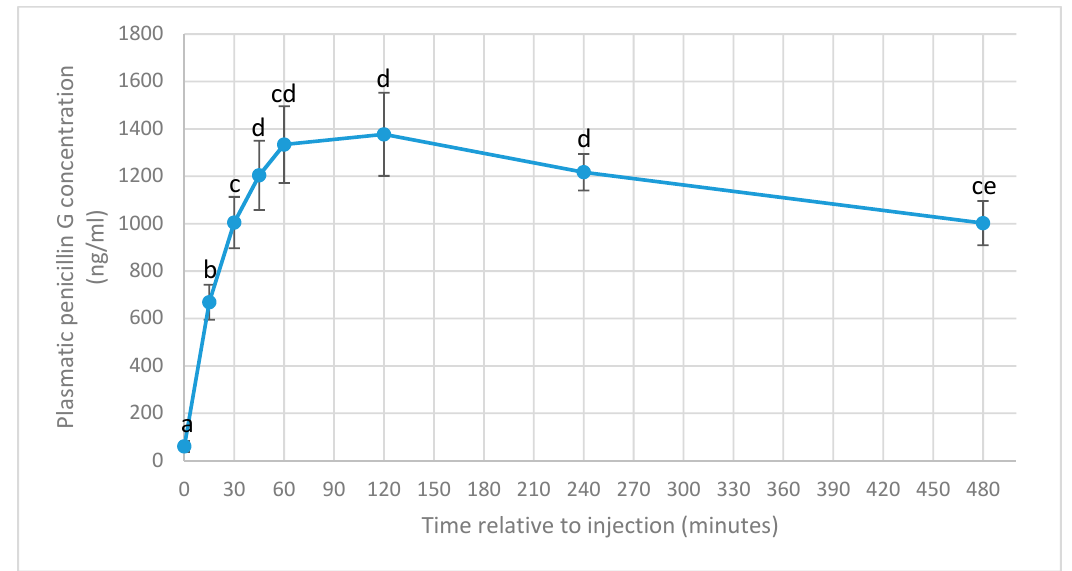
Figure 1. Mean plasma penicillin G concentration (ng/mL) at different sampling times ( − 5, 15, 30, 45, 60, 120, 240, and 480 min) relative to intramuscular administration of 21,000 IU/kg of procaine benzylpenicillin in 12 Belgian Blue cows. Error bars represent the standard error. a–e values bearing different letters indicate a statistical difference ( p < 0.05). Table 1. The plasma concentration (ng/mL) of penicillin G at the different sampling times (minute) for each cow enrolled in the trial and the average concentration (Mean ± standard error) reported in our study. Results of a comparable study by Conlon et al. [23] are displayed in the last column.